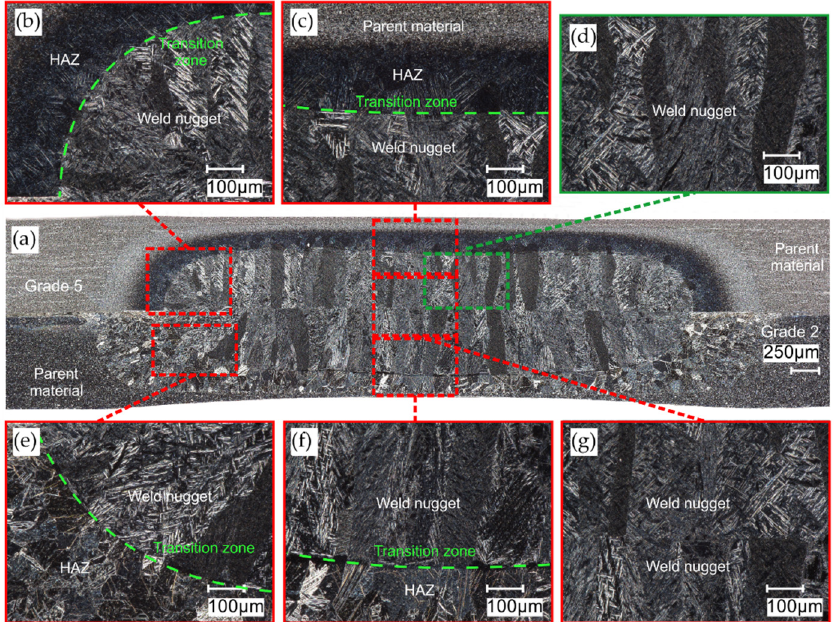
Figure 10. Microstructure of weld in the Gr2–Gr5 joint: ( a ) panorama of the weld; ( b , c , e , f ) transition zone between the weld nugget, HAZ and parent material; ( d ) weld nugget zone and ( g ) weld nugget center.